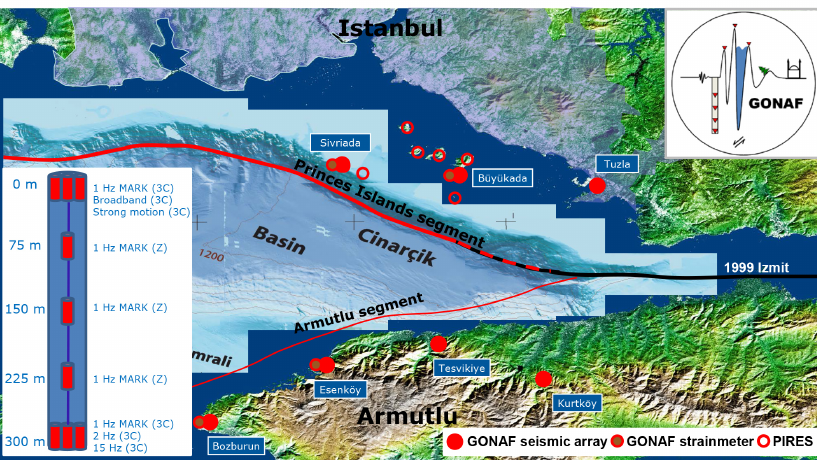
Figure 2. The eastern Marmara region with the Princes Islands segment as the main NAFZ fault trace in this region. Bold red dots indicate locations of the ICDP-GONAF observatory where seismometer arrays were deployed in 300m deep boreholes. Brown dots indicate locations with additional 100m deep strainmeter wells. The inset on the lower left shows the sensor distribution in the GONAF wells including multiple seismic sensors of different natural frequencies to sample the entire frequency band of the seismic wavefield (see text for details). Open red circles are surface-based stations of the PIRES seismic network on the Princes Islands.